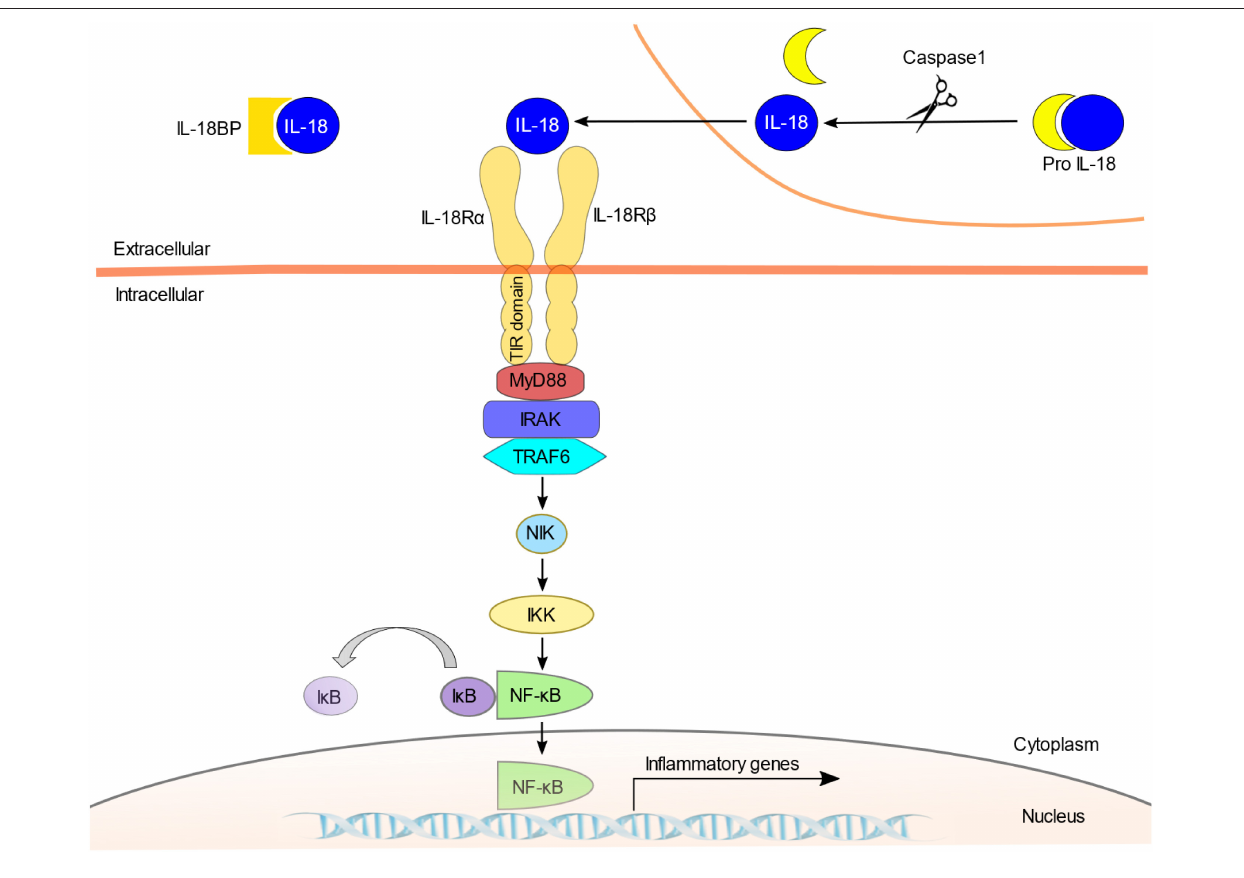
FIGURE 1 | The IL-18 signaling pathway. IL-18 is stored intracellularly as biologically inactive pro-IL-18 and is secreted extracellularly as the bioactive mature molecule after being cleaved by caspase-1. IL-18 is regulated by the endogenous inhibitor IL-18BP. Since IL-18BP has high affinity for IL-18, IL-18BP binds preferentially to IL-18 and inhibits binding to the IL-18R. IL-18 first binds to the IL-18R α ; however, this binding is low-affinity, and the IL-18R β chain is recruited to form a high-affinity heterodimeric complex. The activation of IL-18R recruits MyD88 to the TIR domain and anchors IRAK. Phosphorylated IRAK activates TRAF6, and which in turn phosphorylates NIK. This is followed by the activation of IKK and finally NF- κ B, which initiates the transcription of target genes such as IFN- γ